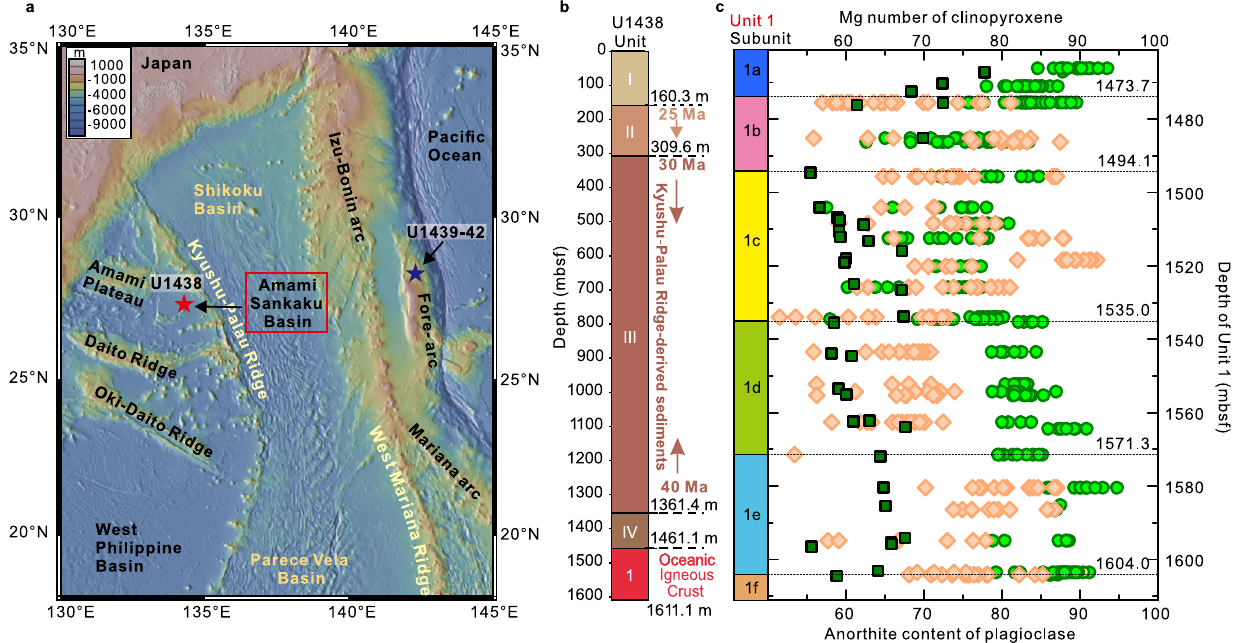
Fig. 1 Location of IODP expeditions 351 (U1438) and 352 (U1439-42) drill sites, stratigraphy of U1438, bulk rock and mineral characteristics of Unit 1 at Site U1438. a Bathymetric map 65 showing the location of Amami-Sankaku Basin and Site U1438 (red star) adjacent to the Kyushu-Palau Ridge (remnant arc), and sites U1439-42 (black star; Expedition 352) in the present-day fore-arc. Figure made with GeoMapApp (www.geomapapp.org). b Unit thicknesses and ages at Site U1438. Units are coloured for visualisation. c subunit information for Unit 1 including Mg number (100 ∗ Mg/(Mg + Fe 2 + )) of clinopyroxene (green circles), anorthite content (An%) of plagioclase (orange diamonds), and bulk rock 100 ∗ Mg/(Mg + Σ Fe) (dark green squares) versus depth. Colours of subunits are also used in all other fi gures (main text and